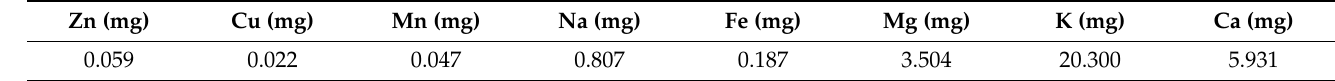
Table 4. The content of main mineral elements in old leaves of T. sinensis (content per